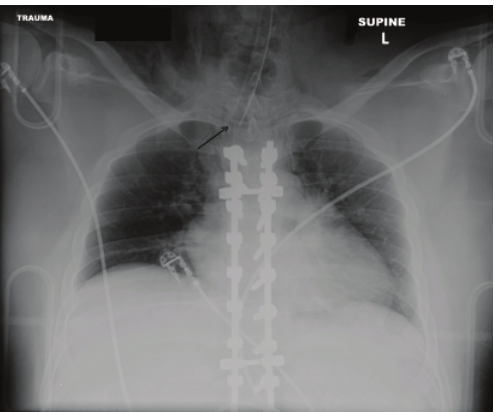
Figure 1: Chest X-ray after reintubation. Arrow: tip of ETT is at the thoracic inlet.